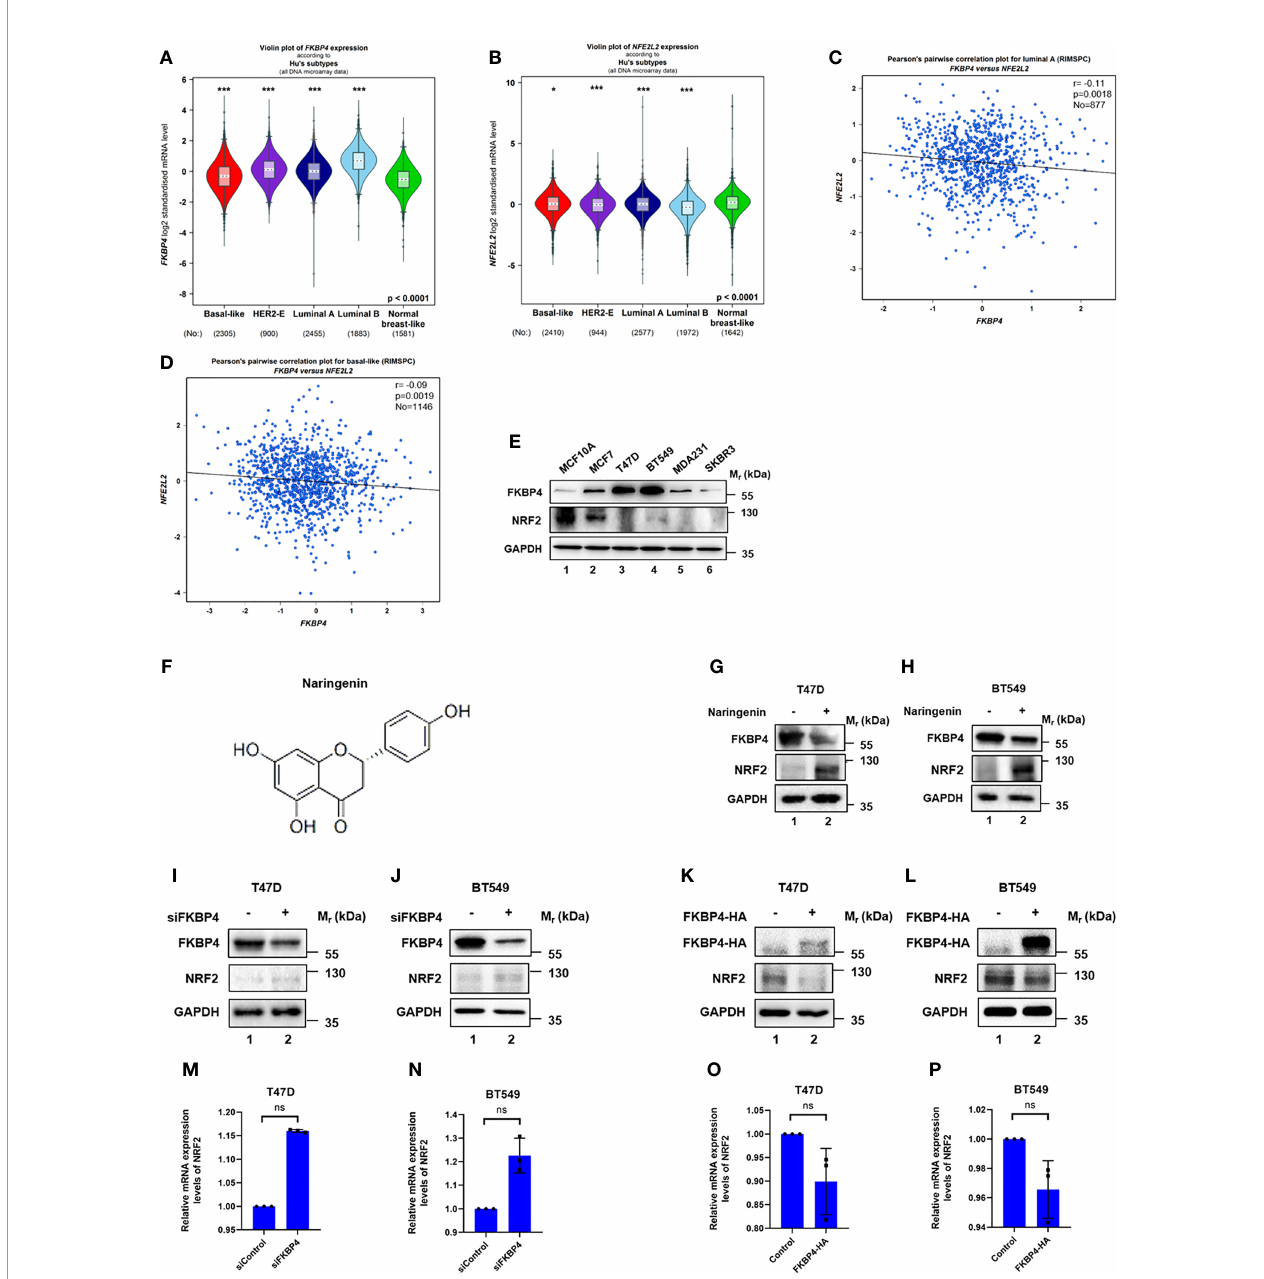
FIGURE 1 | FKBP4 negatively regulates NRF2 at protein level. (A) A violin plot indicated upregulated FKBP4 in luminal A, luminal B, HER2-positive and basal-like subtype of BC patients than the normal group. (B) A violin plot indicated downregulated NRF2 in luminal A, luminal B, HER2-positive and basal-like subtype of BC patients than the normal group. (C) Pearson ’ s pairwise correlation plot of FKBP4 and NRF2 in luminal A subtype of BC patients, r = − 0.11, p = 0.0018, No = 877. (D) Pearson ’ s pairwise correlation plot of FKBP4 and NRF2 in basal-like subtype of BC patients, r = − 0.09, p = 0.0019, No = 1146. (E) Representative western blot analysis results of FKBP4, NRF2, and endogenous control GAPDH. Western blot analysis showed a negatively correlated expression of FKBP4 and NRF2 in BC and normal breast cells. (F) Chemical structure of naringenin. (G, H) Representative western blot analysis results of FKBP4, NRF2, and endogenous control GAPDH. Western blot analysis showed decreased FKBP4 expression and increased NRF2 expression in T47D and BT549 cells treated by 100 nM naringenin for 48 h (I, J) Representative western blot analysis results of FKBP4, NRF2, and endogenous control GAPDH. Western blot analysis showed silencing FKBP4 resulted in upregulation of NRF2 in T47D and BT549 cells. (K, L) Representative western blot analysis results of FKBP4-HA, NRF2, and endogenous control GAPDH. Western blot analysis showed overexpressing FKBP4 resulted in downregulation of NRF2 in T47D and BT549 cells. (M, N) RT-qPCR showed silencing FKBP4 resulted in no signi fi cant changes of NRF2 in T47D and BT549 cells (n = 3 independent biological replicates). (O, P) RT-qPCR showed overexpressing FKBP4 resulted in no signi fi cant changes of NRF2 in T47D and BT549 cells (n = 3 independent biological replicates). *p <0.05, ***p <0.001, ns,